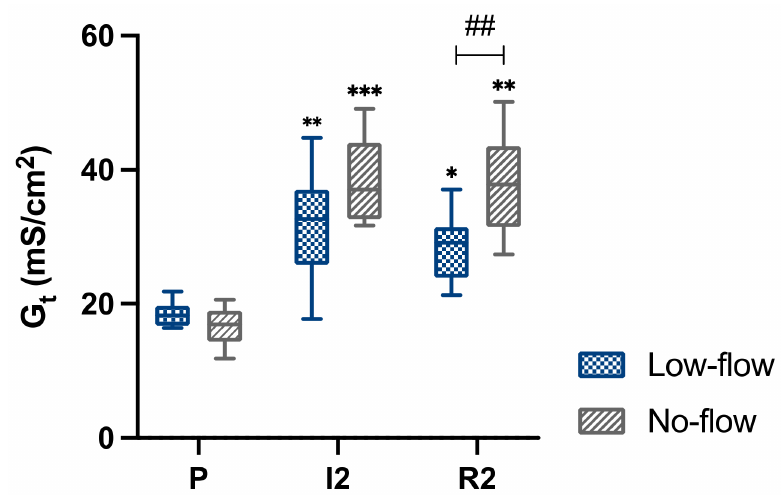
Figure 11. Box-plot diagram of the tissue conductance (G t ) during pre-ischaemia (P), following 120 min of ischaemia (I2) and after 120 min of reperfusion (R2) in jejunum subjected to either LF or NF ischaemia. Significant differences of the time points compared to pre-ischaemia are marked with an asterisk (* p < 0.05; ** p < 0.01; *** p < 0.001), significant differences between the groups are indicated with a horizontal bar and accompanying hash (## p < 0.01).